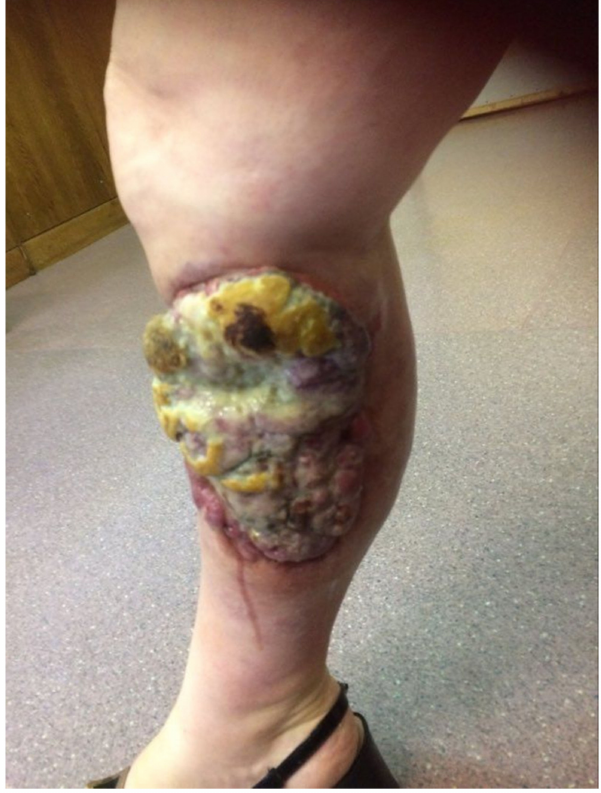
Figure 7. Locally advanced, unresectable MCC with in-transit metastases (stage III) in immunocom- promised patient (patient with CLL, chronic lymphocytic